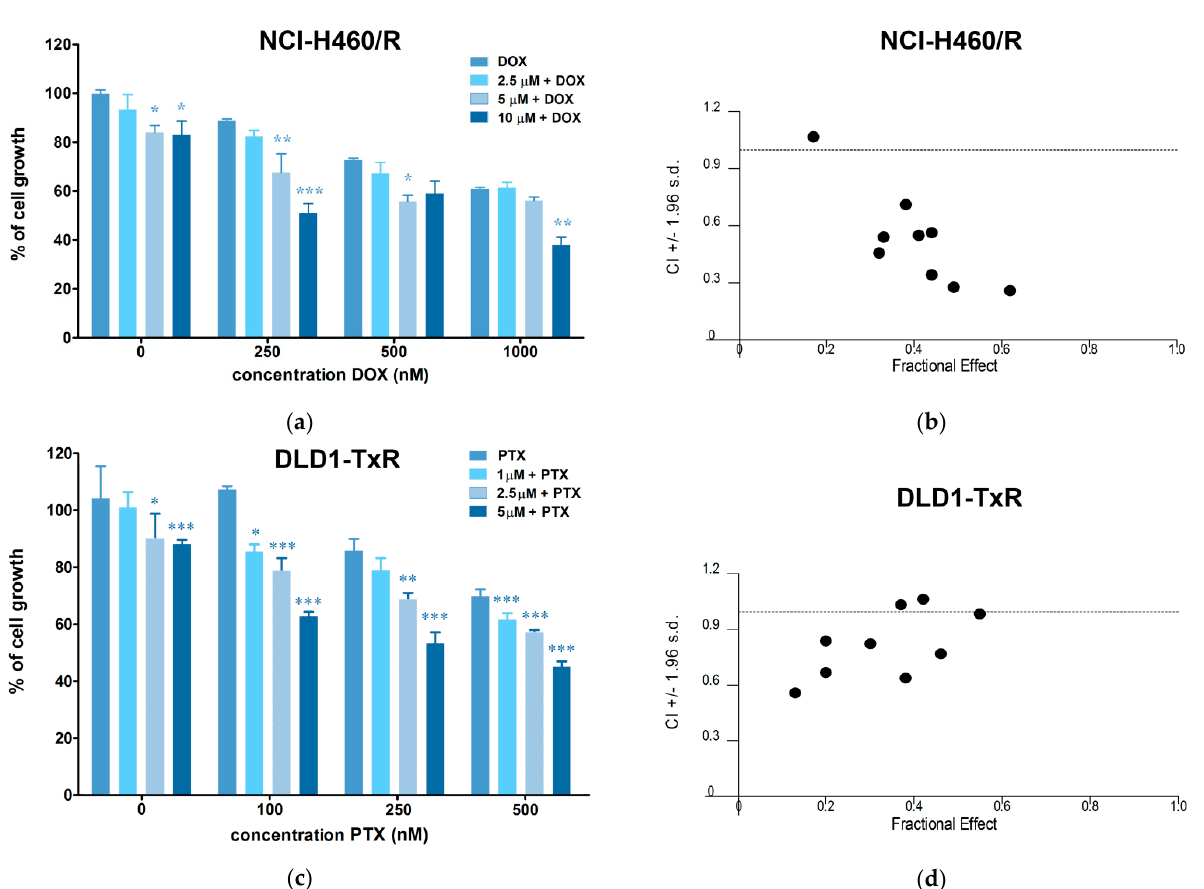
Figure 7. Hsp90 inhibitors compound 5 chemosensitizes MDR cancer cells to doxorubicin (DOX) and paclitaxel (PTX). ( a ) Cell growth inhibition by DOX in single and combination treatments with Hsp90 inhibitors in MDR NCI-H460/R cells. ( b ) Synergistic type of interaction between 5 and DOX. ( c ) Cell growth inhibition by PTX in single and combination treatments with Hsp90 inhibitors in MDR DLD1-TxR cells. ( d ) Synergistic type of interaction between 5 and PTX. The results are expressed as mean ± SEM. Statistical significance to DOX or PTX alone from three experiments: p < 0.05 (*), p < 0.01 (**), p < 0.001 (***). CI values below 1 depict synergistic effect. Table 3. Relative reversal of doxorubicin (DOX) and paclitaxel (PTX) resistance in NCI-H460/R and DLD1-TxR cells induced by Hsp90 inhibitor. Compound DOX IC 50 (nM)